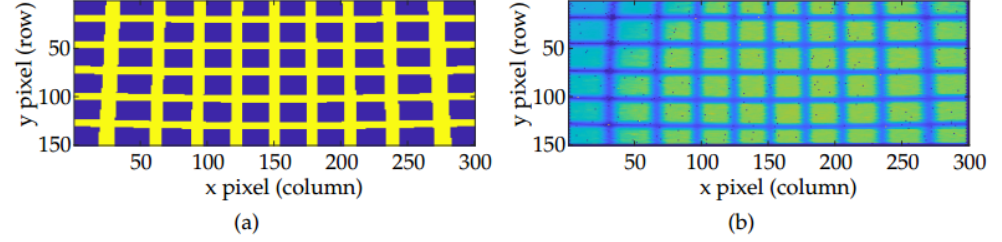
Figure 8. ( a ) Simulated and ( b ) experimental image of the grid pattern at 3.8 m using the 30 × 20 ◦ FOV